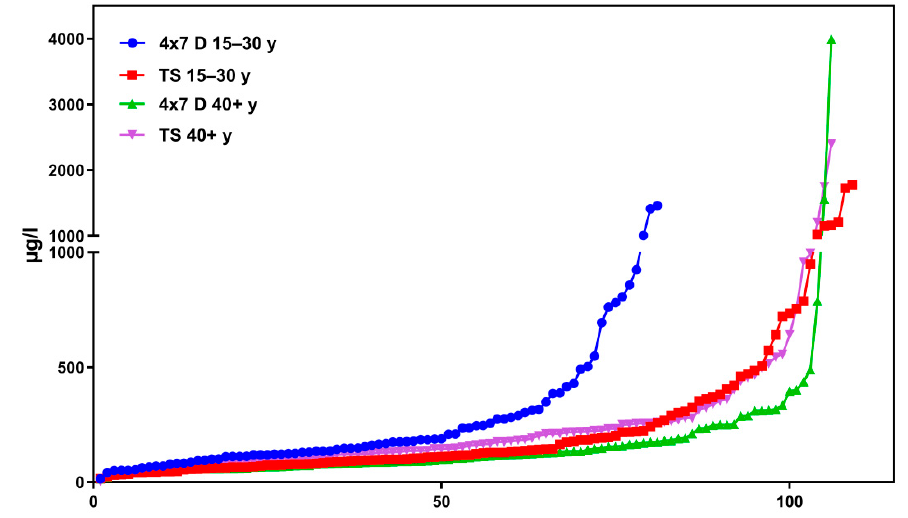
Figure 6. Results for the sum of MEHP + 5OH-MEHP + 5oxo-MEHP + 5cx-MEPP in the morning urine in ascending order. All test subjects age >15 years. Comparison of longitudinal and cross-sectional studies. 4 × 7 d = course of the year study; TS = “Tübingen Survey” y = age in years. X-axis: urine samples in corresponding order.